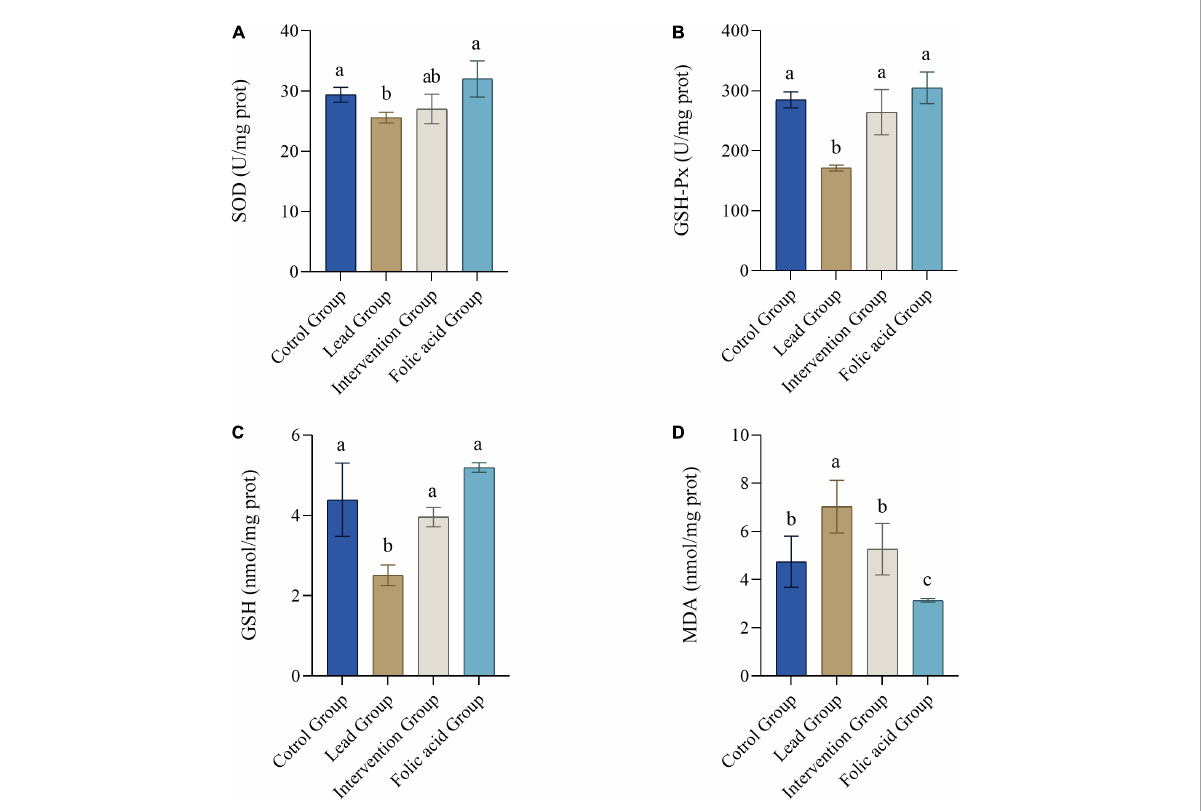
FIGURE2 Effects of folic acid on superoxide dismutase (SOD) (A) , GSH-Px (B) activities and glutathione (GSH) (C) , malondialdehyde (MDA), (D) contents in kidney of lead-exposed rats ( n = 10). Data were presented as mean ± SD. Different superscript letters indicate differences ( P < 0.05).